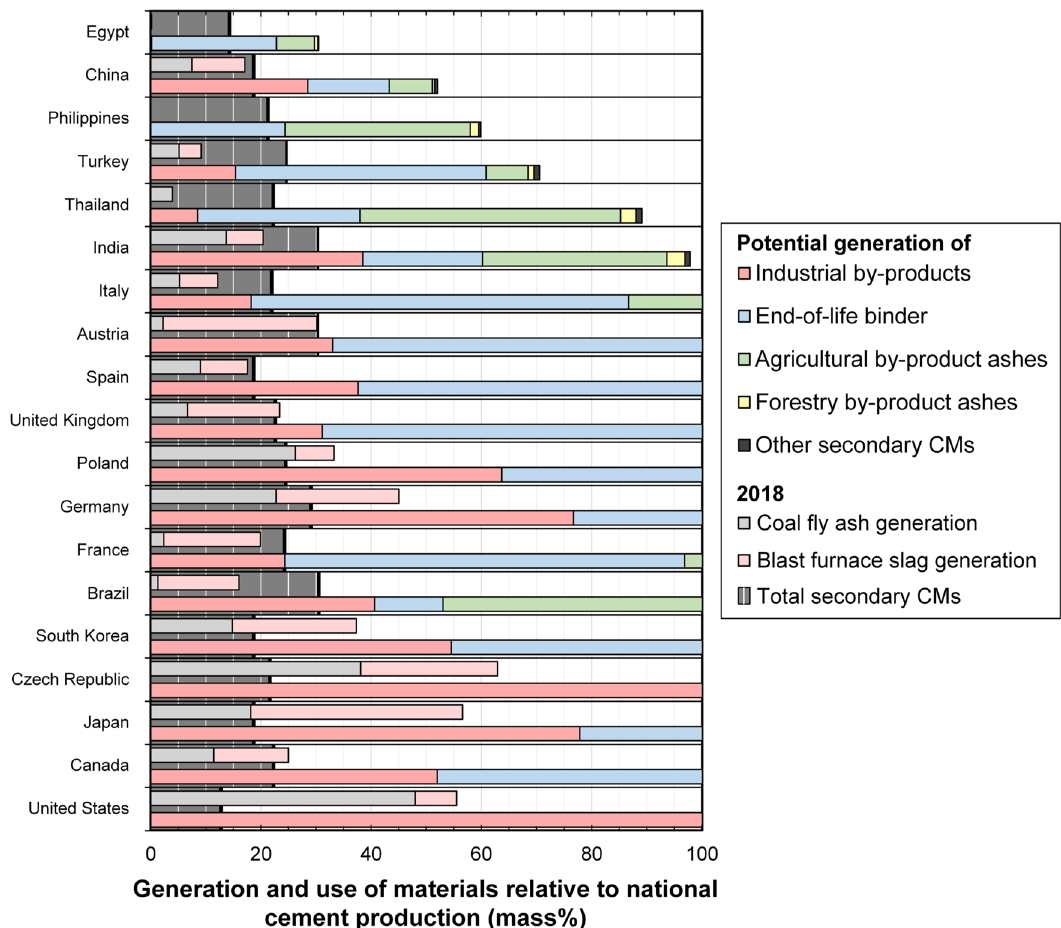
Fig. 4 | Current (2018) vs. potential substitution of clinker for secondary cementitious materials (CMs) in several countries. Clinker substitution poten- tialsfor Italy through the United States (as listedin Fig. 4), were greater than 100% in2018,soareducednumberofsecondaryCMsareshownforthesecountries(see Supplementary Information S2 for the full dataset). Potential generation of